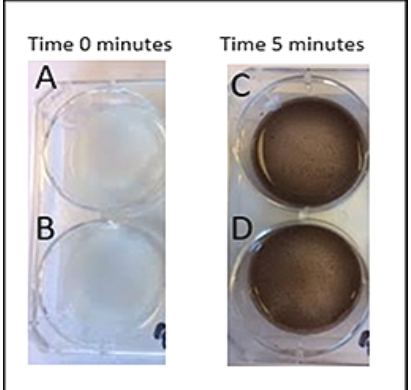
Figure 7. Comparison of 20% silver nitrate solution and 1.14 M silver nitrate solution upon addition of urate. Top photos: 20% silver nitrate; bottom photos: 1.14 M silver nitrate solution. First column of photos: 0 min elapsed; second column of photos: 5 min elapsed.